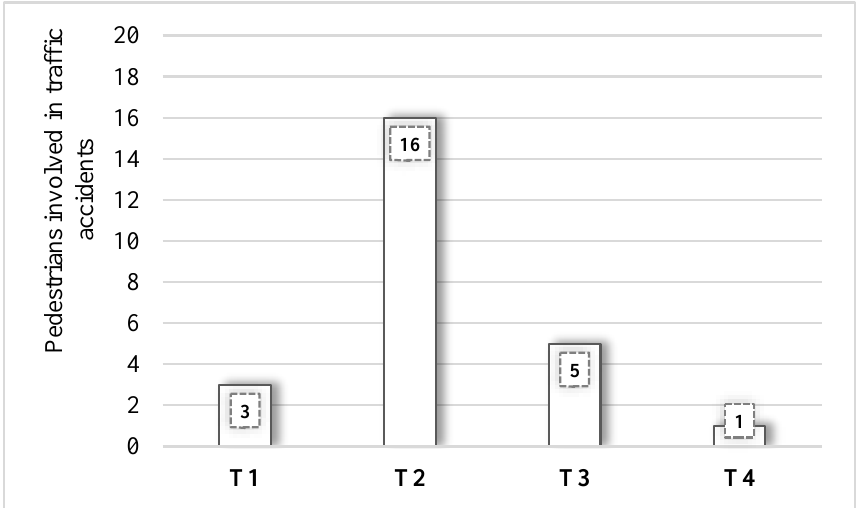
Figure 8. Pedestrians involved in driveway-related accidents for each access connection transition shape.